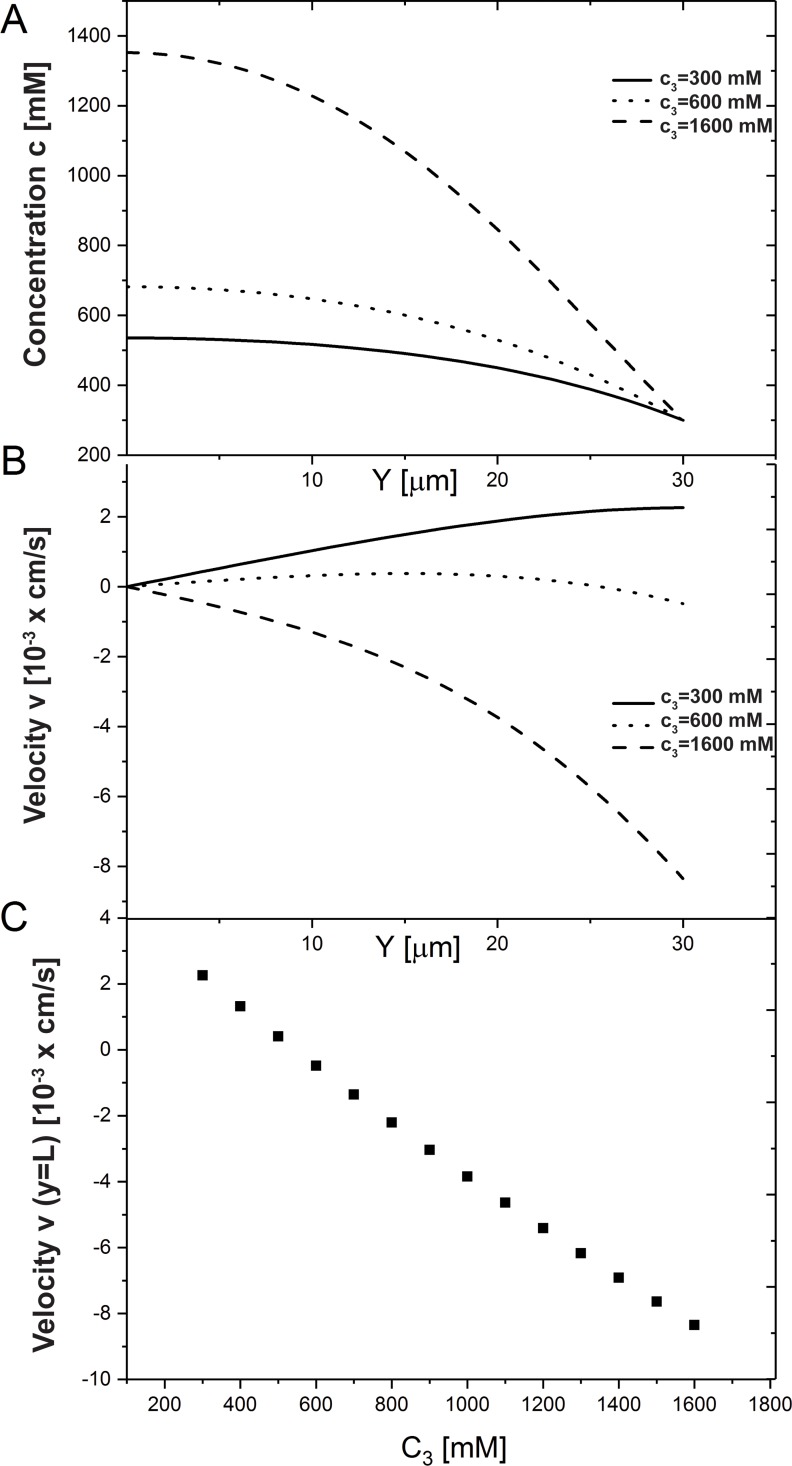
Influence of internal cell concentration c3.(A) Ion concentration and (B) water velocity profiles along the IC. (C) The velocity at the end of the cleft v(L) as c3 increases from 200 to 1600 mM. The IC length is L = 30mM, and c4 = 300mM.